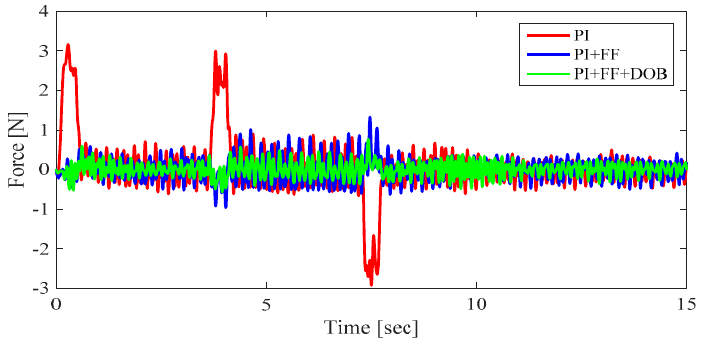
Figure 11. Tracking error for three different control cases.